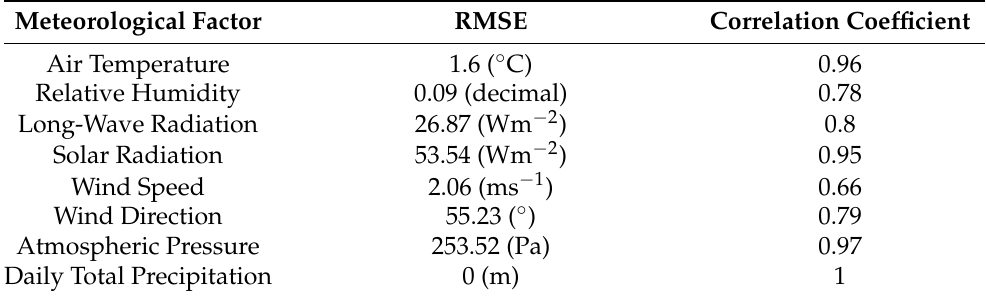
Table 1. Root mean squared error (RMSE) and the Correlation Coefficients for comparison between the weather monitoring data and the down-scaled hourly